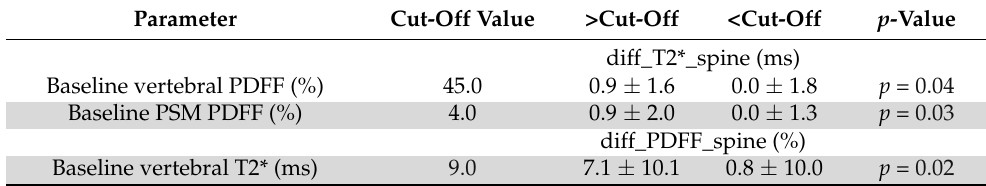
Table 2. Subgroup